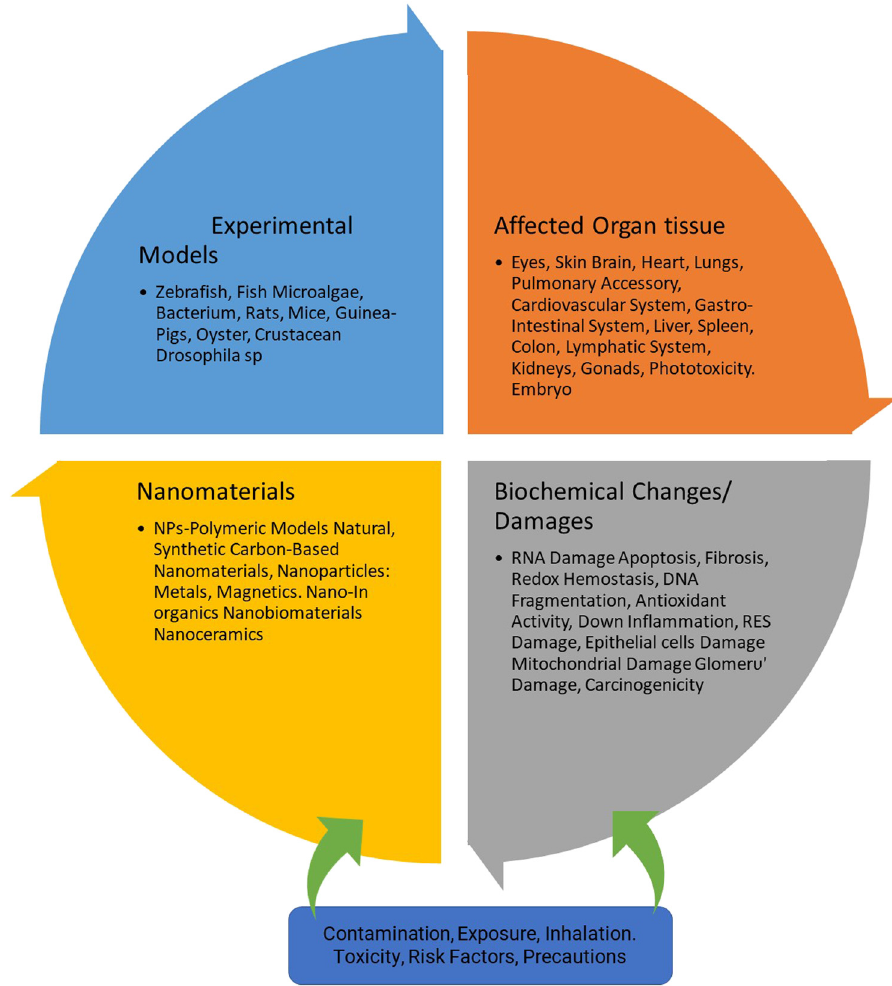
Figure 17: Toxicity cycle components for nanotoxicity causative factors, experimental evaluation vehicles, organs, and tissues toxicity, and probably e ff ected biochemical changes and observed